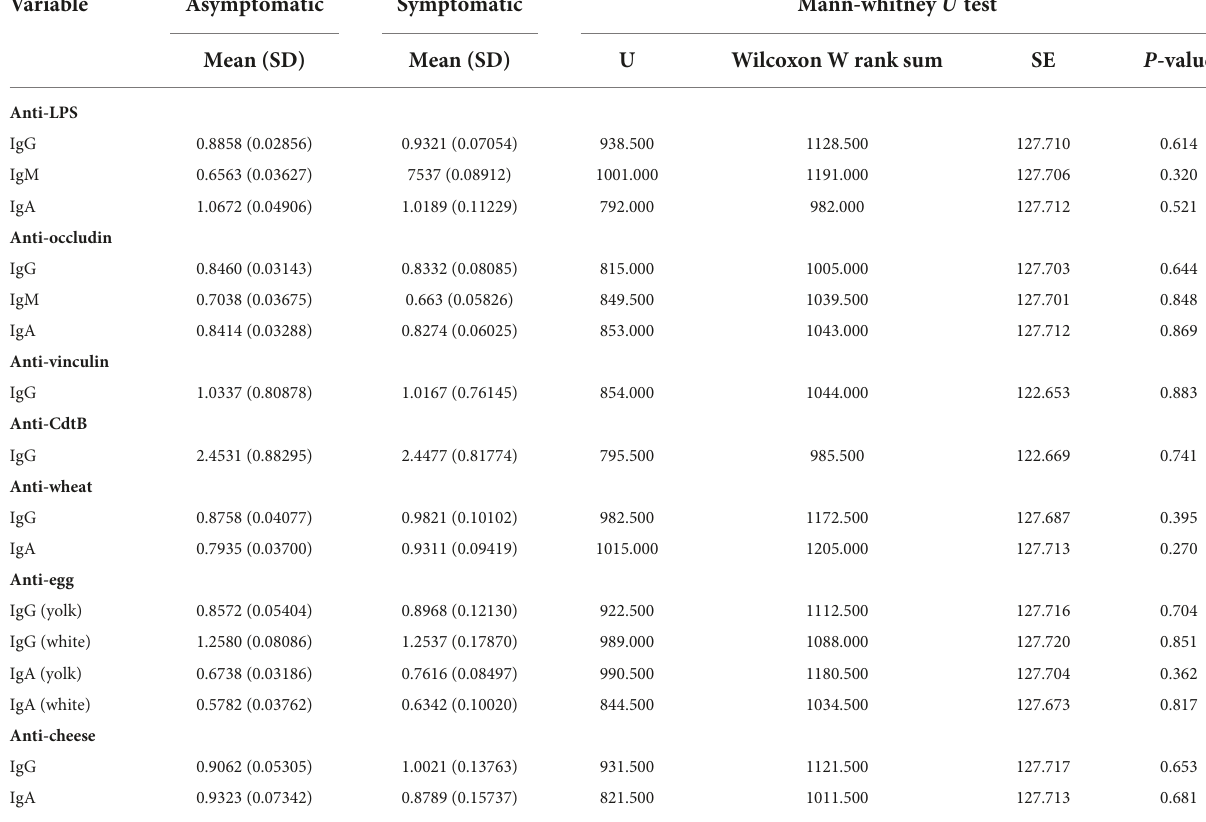
TABLE 2 Difference in average biomarker concentrations between symptomatic and asymptomatic participants ( n = 111).